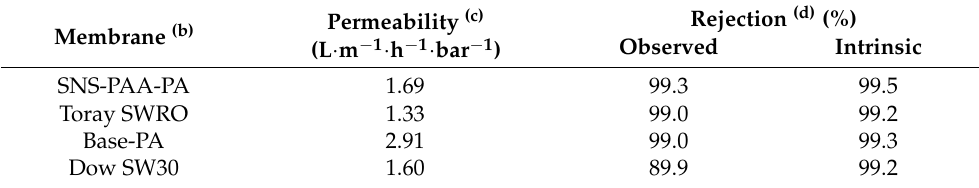
Table 1. Separation performance of the SNS-PAA-PA and commercial membranes (a) . Membrane